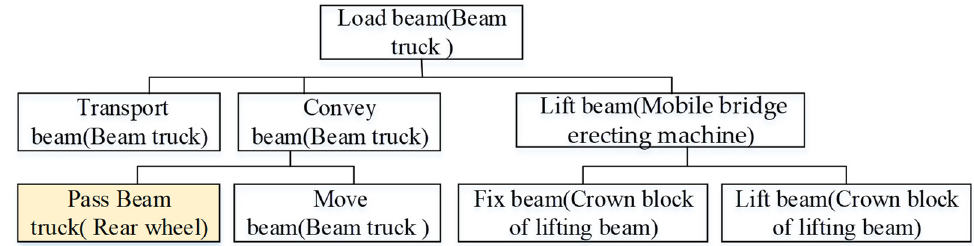
Figure 20. Function breakdown of the preliminary solution.